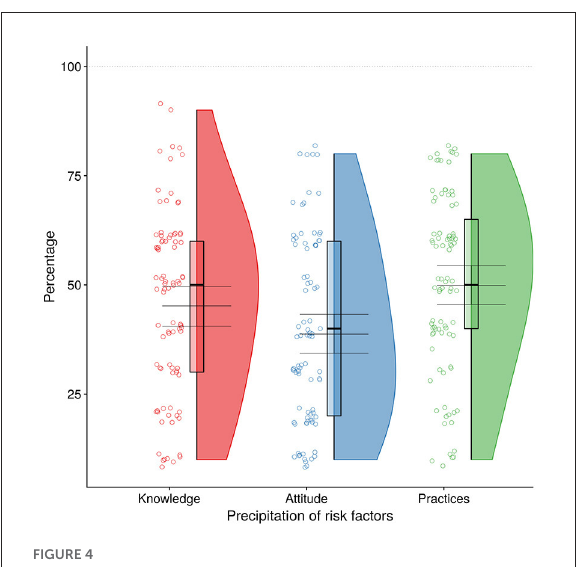
FIGURE4 Precipitation of risk factors i.e., knowledge, attitudes and